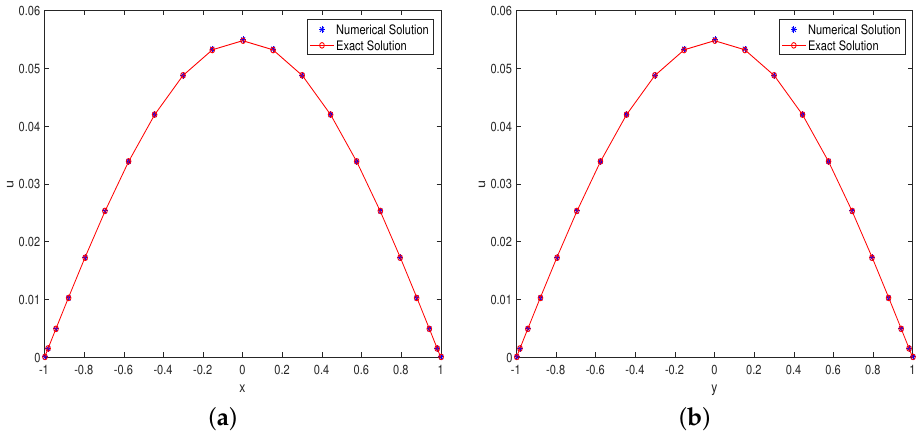
Figure 3. Comparison between the numerical solution and the exact solution in two directions for τ = 0.01, N x = N y = 20, α = 0.3, β = 0.7, T = 1. ( a ) x direction with y = 0; ( b ) y direction with x = 0 Example 2. The 2D Rayleigh–Stokes problem for a heated generalized second-grade fluid with fractional